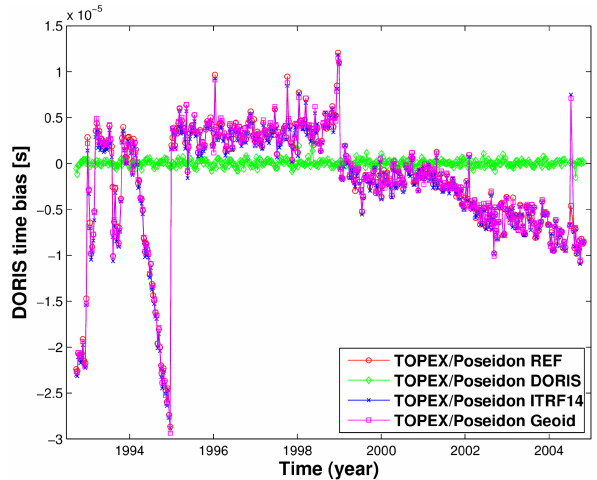
Figure A1. DORIS system time bias of TOPEX/Poseidon REF, DORIS, ITRF14, and Geoid orbits.